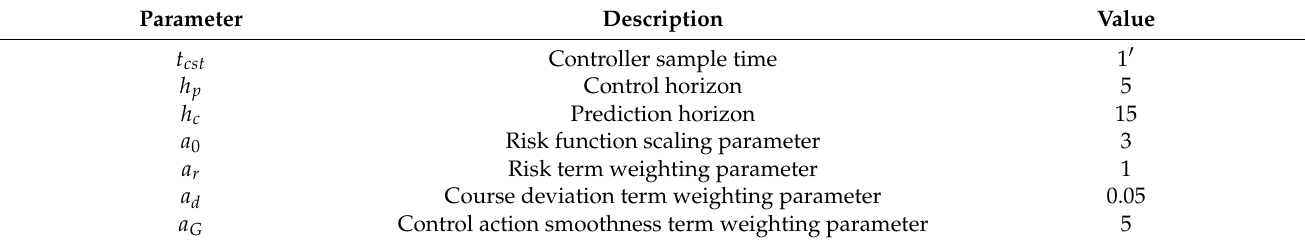
Table 2. MPC tuning parameters.